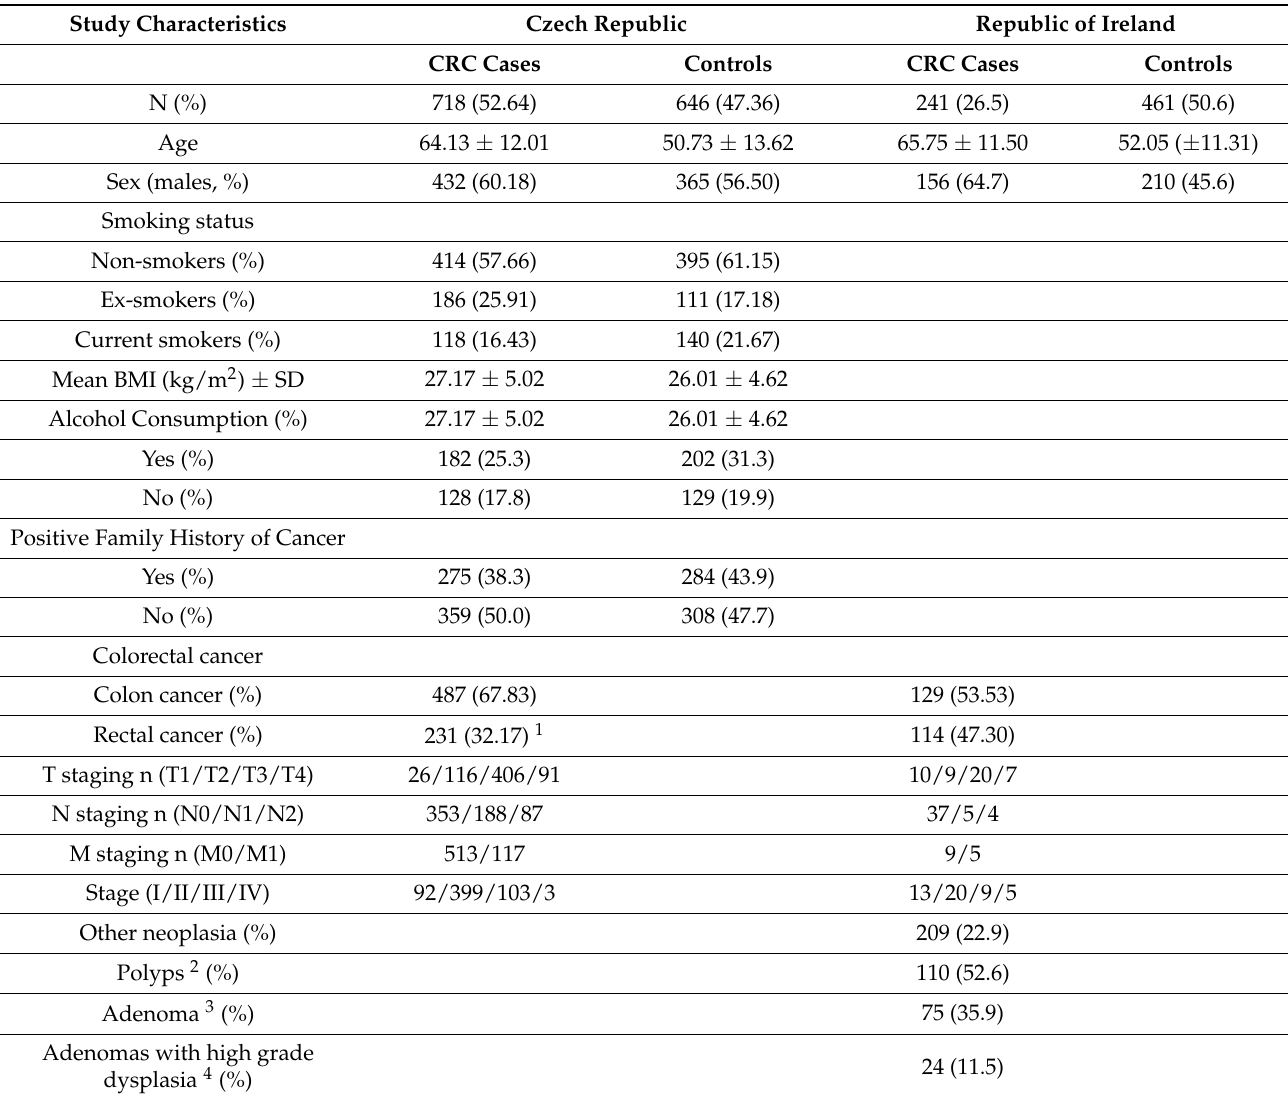
Table 1. Selected baseline characteristics of the colorectal neoplasia cases and the controls in the Czech and Irish